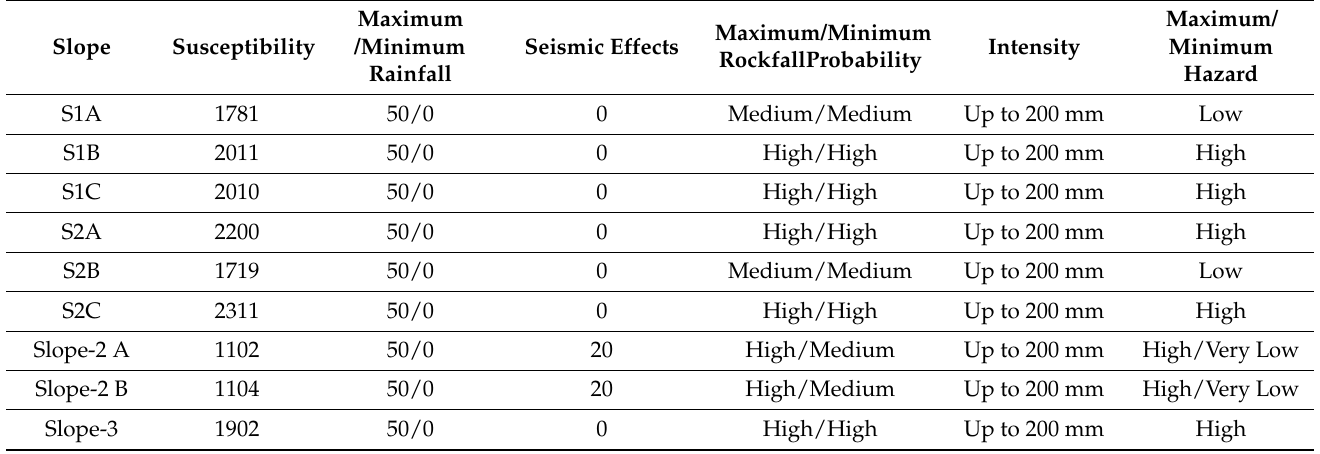
Table 12. Rockfall susceptibility, probability and hazard of each slope according to the proposed